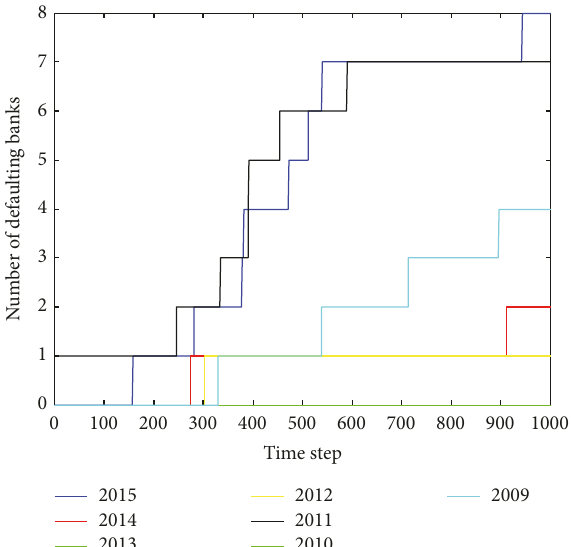
Figure 3: Time variations in number of defaulting banks in Kenyan banking system with the network estimated by maximum entropy estimation method.